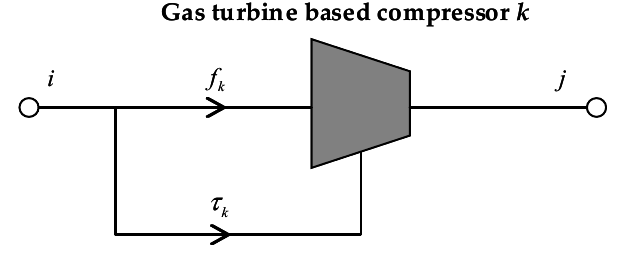
Figure 2. Compressor driven by a gas turbine.